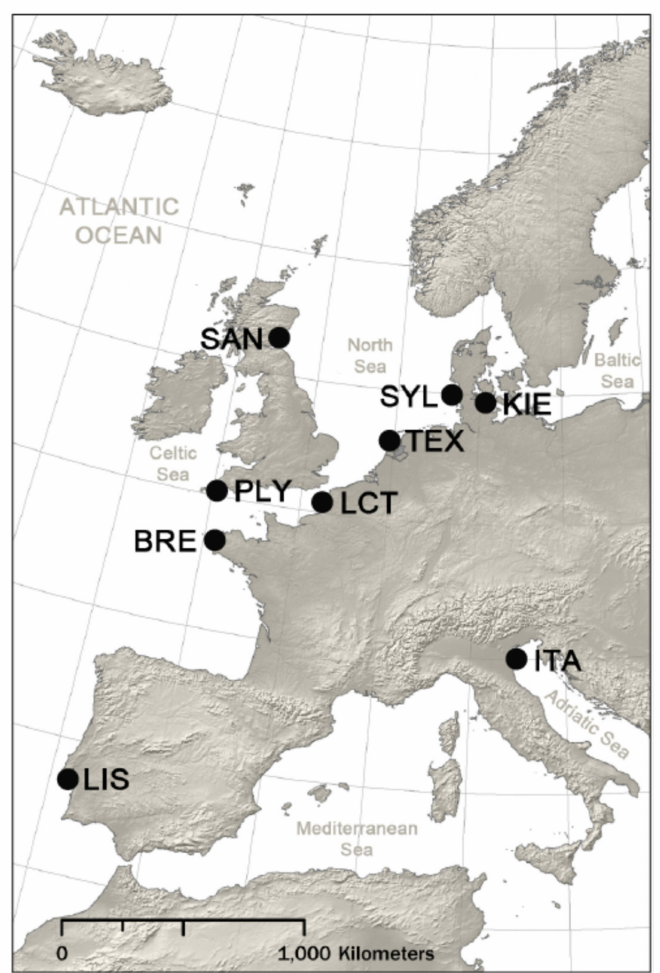
Figure 2. Map showing nine M. arenaria sampling locations across Europe: Comacchio, Italy (ITA); Lisbon, Portugal (LIS); Brest, France (BRE); Plymouth, UK (PLY); Saint Andrews, UK (SAN); Le Crotoy, France (LCT); Balgzand, Netherlands (TEX); Sylt, Germany (SYL); Kiel, Germany